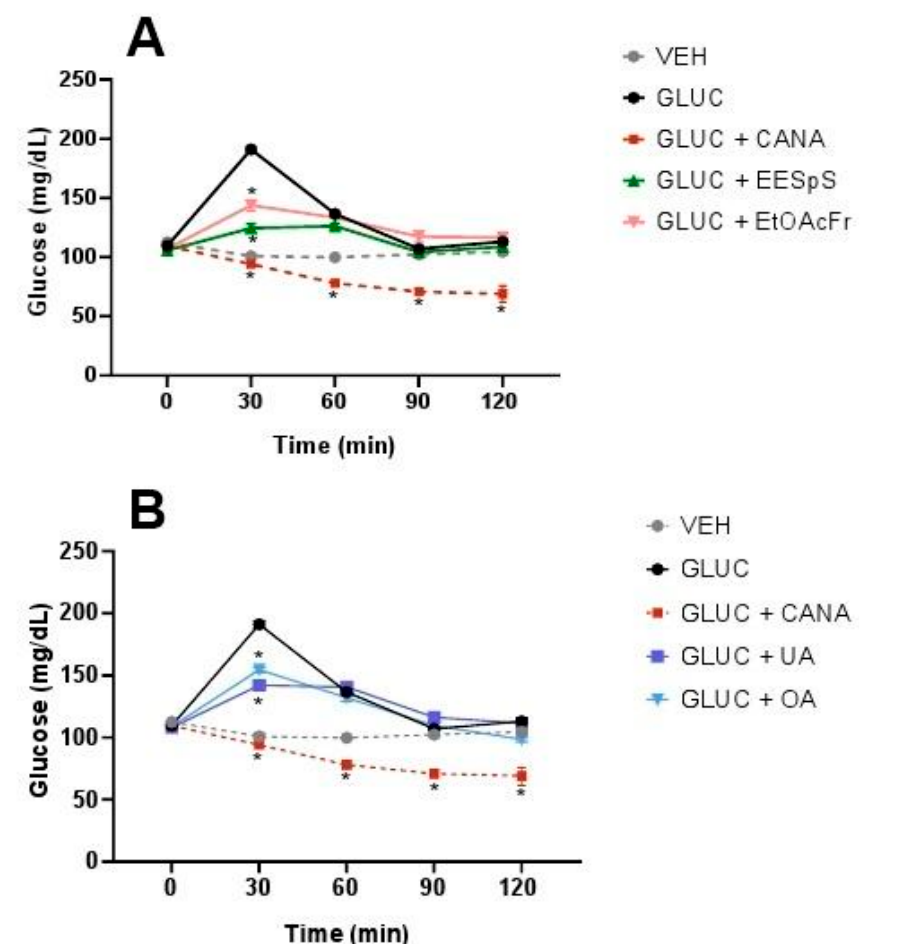
Figure 4. Effect of products obtained from the stems from S. polystachya in oral glucose tolerance test (OGTT). ( A ) OGTT of groups treated with glucose, acarbose, EESpS and EtOAcFr, as well as vehicle. ( B ) OGTT of groups treated with glucose, acarbose, UA and OA, as well as vehicle. Results shown as mean ± SEM ( n = 6). * p > 0.05 significantly different vs. glucose group values at the same time. (Two-way ANOVA followed by Dunnett post hoc test) ACAR: acarbose; GLUC: glucose; EESpS: ethanolic extract of stem; EtOAcFr: ethyl acetate fraction; UA: ursolic acid and OA: oleanolic acid.